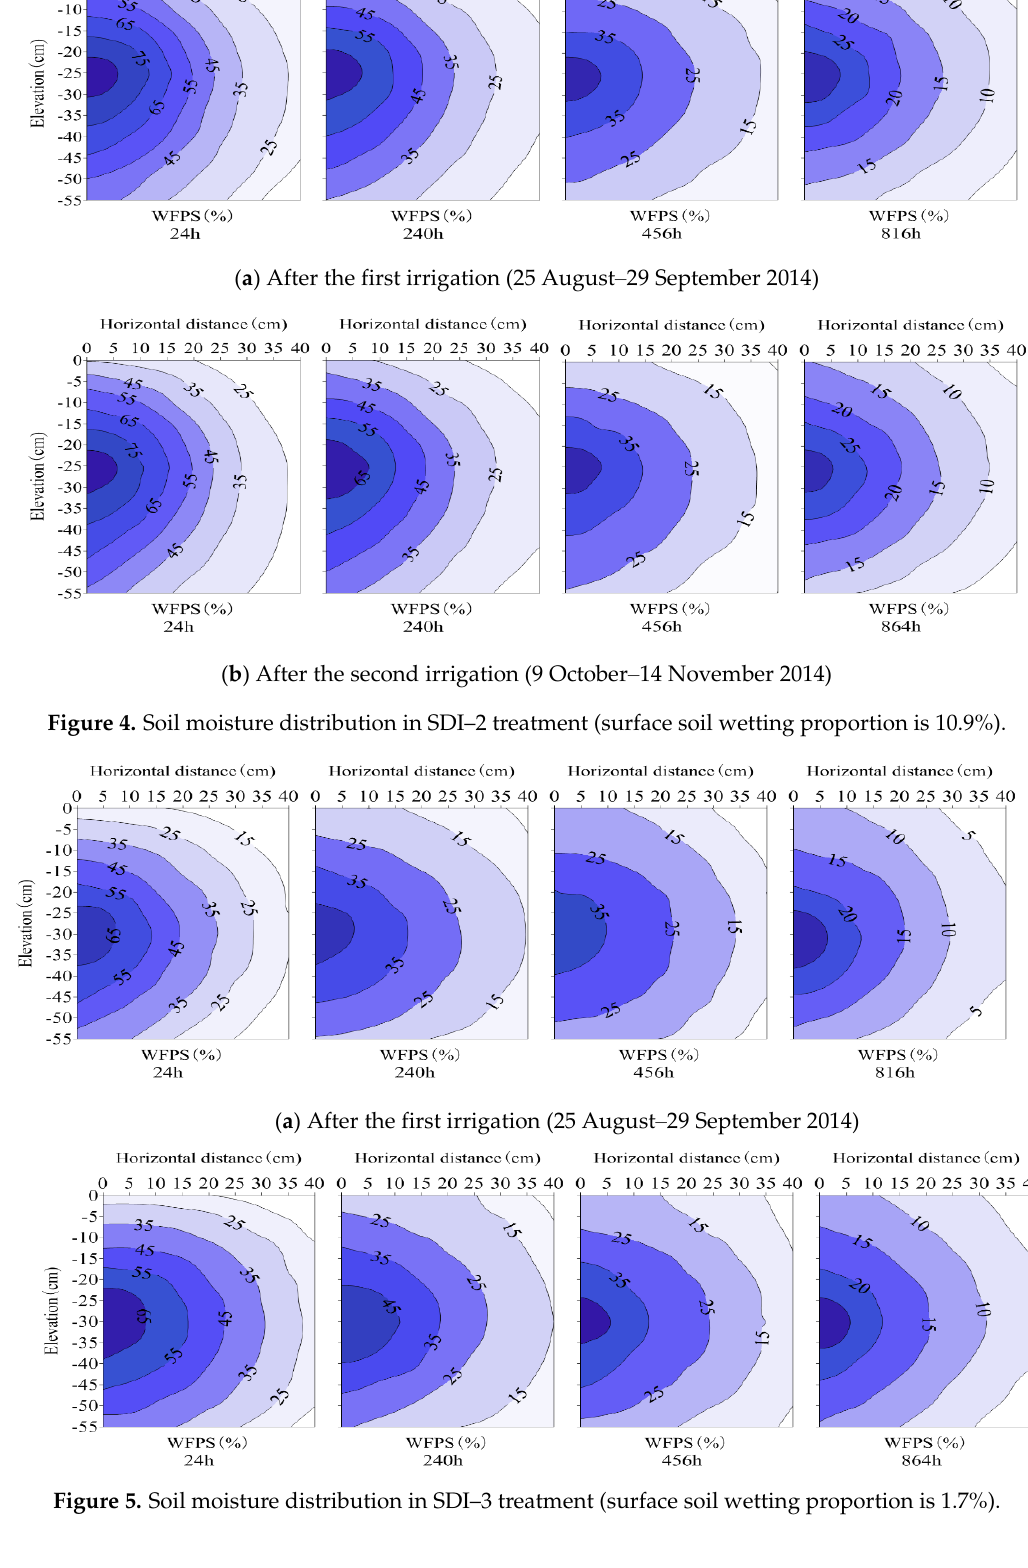
Figure 5. Soil moisture distribution in SDI – 3 treatment (surface soil wetting proportion is 1.7%).